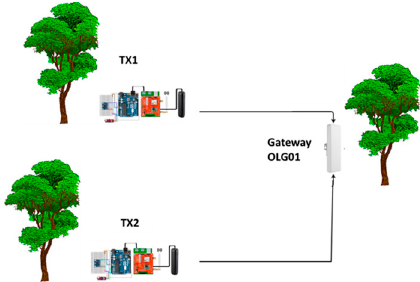
Figure 4. The STAR Topology of the Sensor Nodes and Gateway.